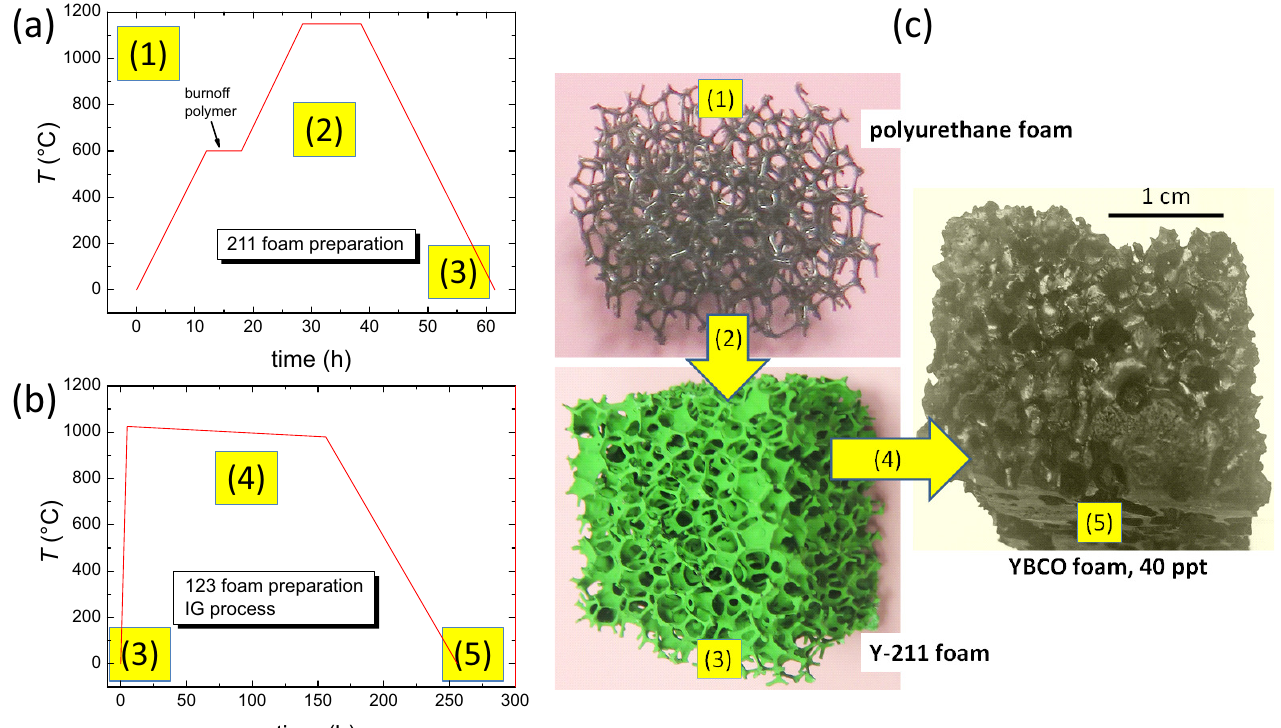
Figure 1. ( a ) Heat treatment to obtain the Y211 foam, ( b ) heat treatment (IG-process) converting the Y-211 foam to an superconducting YBCO foam. ( c ) Illustration of the foam samples at different process stages (1), (3) and